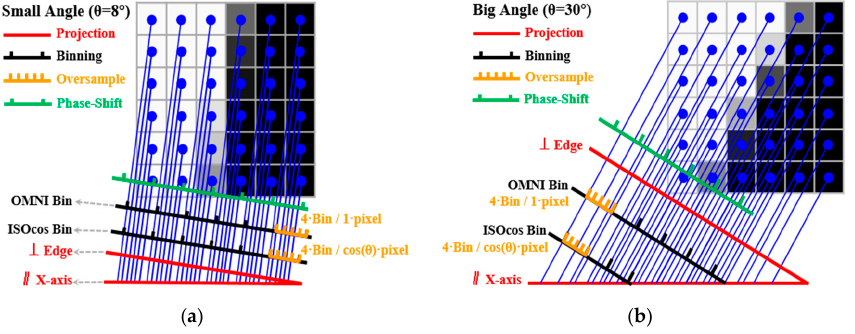
Figure 1. Diagrams of projection and binning in edge method (OSR = 4): ( a ) when the edge angle is small ( θ = 8 deg), ( b ) when the edge angle is big ( θ = 30 deg).